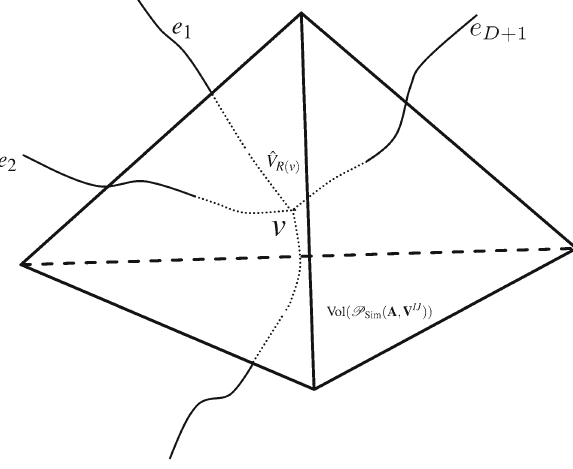
Fig. 4 The semiclassical consistency requires that the expectation value of the usual D-volume operator ˆ V R (v) with respect to || N , V IJ (cid:19) s should be equal to the volume Vol ( P Sim ( A , V IJ )) of the classical D- simplex P Sim ( A , V IJ